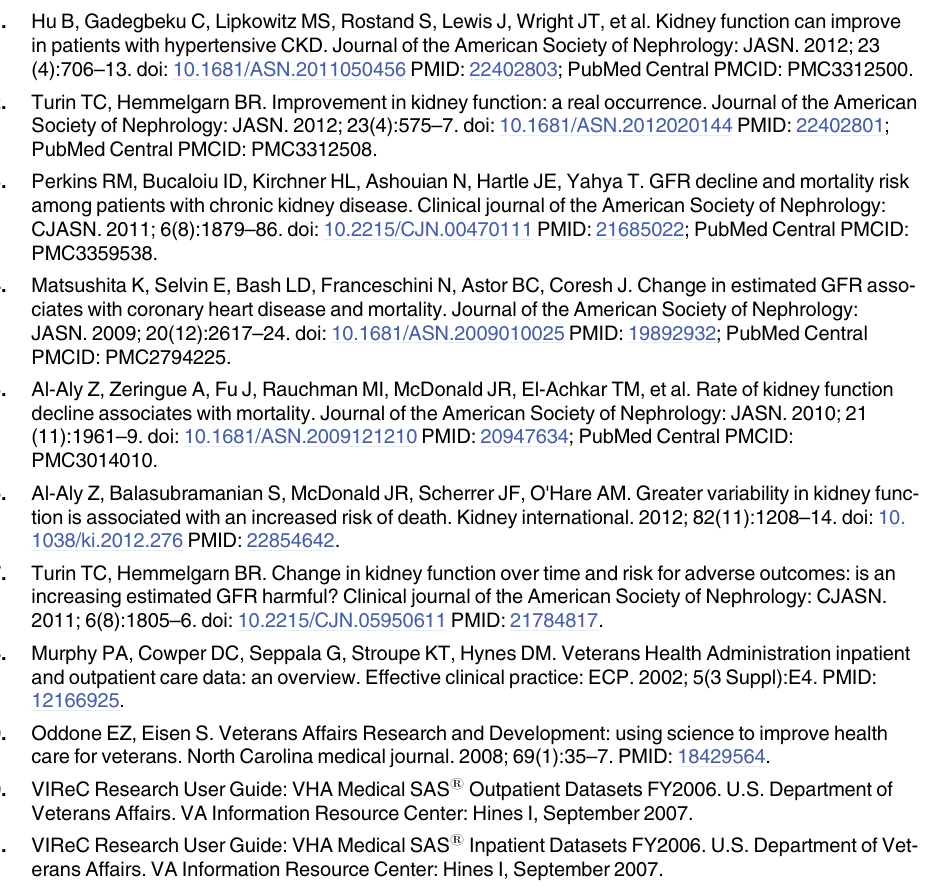
S1 Table. Change in kidney function and the risk of death controlling for initial eGFR. S2 Table. Adjusted associations of trajectory types. S3 Table. Risk of death by trajectory. S4 Table. Risk of death of trajectory